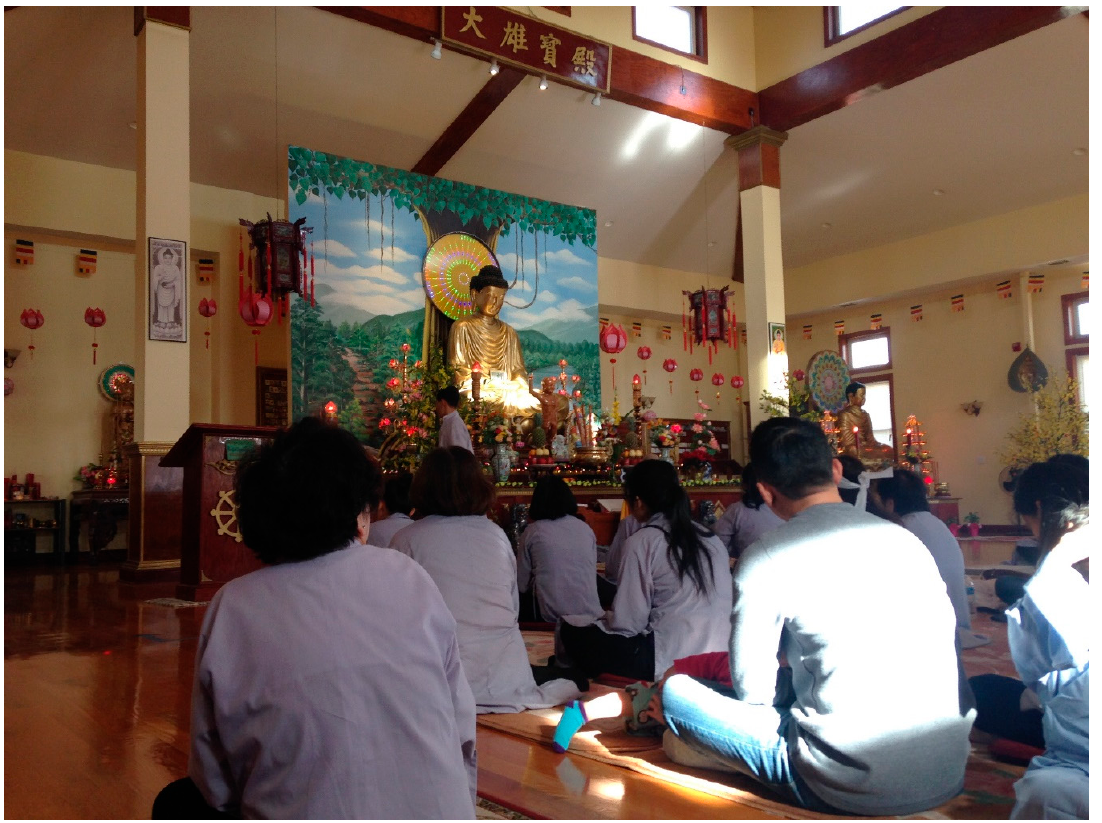
Figure 5. Main ceremonial hall at Chùa Giác Lâm (Lansdowne, PA). Source: www.jivaka.net.